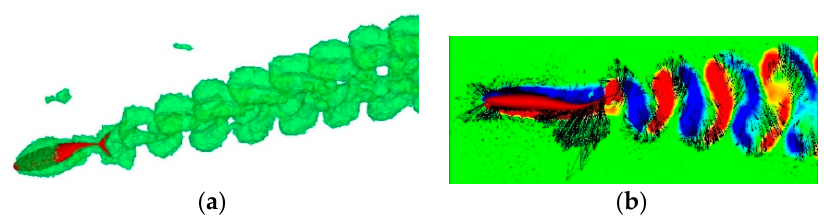
Figure 9. Vortex pattern in the wake of the thunniform bio-inspired mode: ( a ) three-dimensional case; ( b ) two-dimensional case.